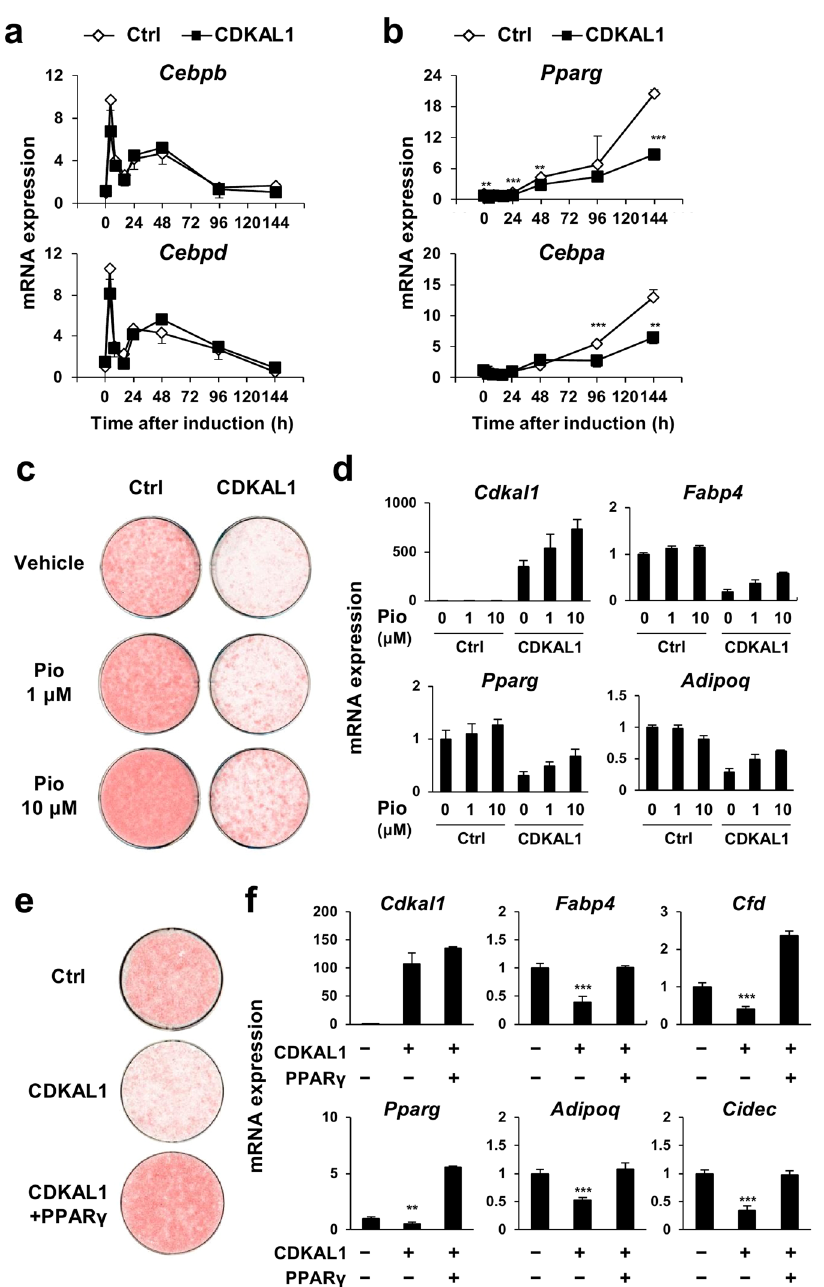
Figure 3. Suppression of PPAR γ expression by CDKAL1 contributes to the anti-adipogenic action of CDKAL1. ( a , b ) Time course of gene expression levels of early adipogenic regulators, C/EBP β and C/EBP δ ( a ) and late regulators, PPAR γ and C/EBP α ( b ) during adipocyte differentiation of 3T3-L1 cells expressing CDKAL1 (n = 3). ( c , d ) Effect of PPAR γ agonist pioglitazone on lipid accumulation ( c ) and gene expression ( d ) in differentiated 3T3-L1 cells expressing CDKAL1 (n = 3). ( e , f ) Effect of coexpression of PPAR γ on lipid accumulation ( e ) and gene expression ( f ) in differentiated 3T3-L1 cells expressing CDKAL1 (n = 3, ** p < 0.005, *** p < 0.0005 vs control group by Dunnett’s